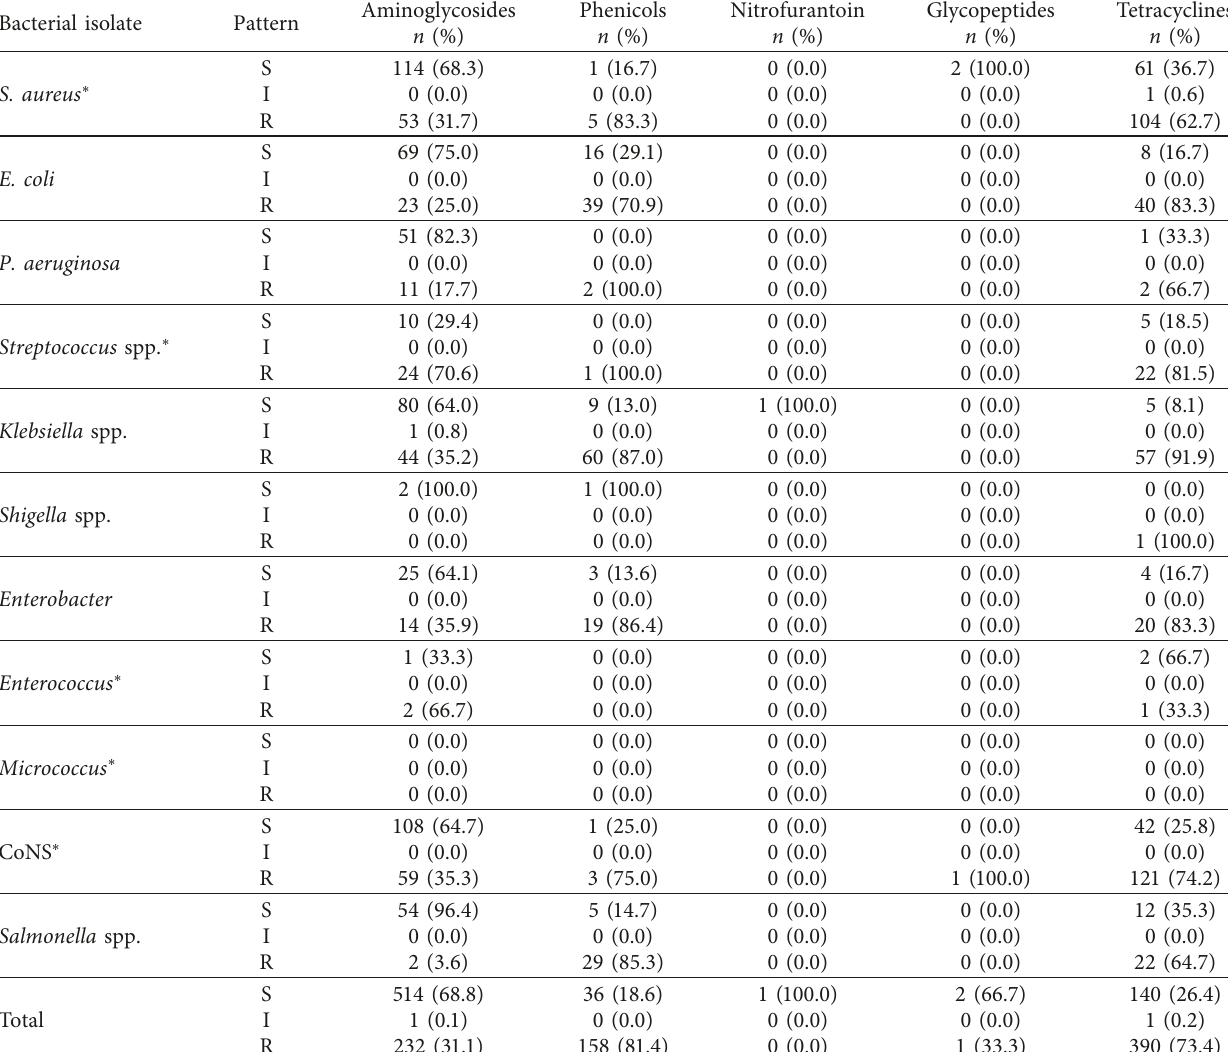
Table 4: Antimicrobial susceptibility pattern of bacterial isolates from blood culture at St. Dominic Hospital in Akwatia. Bacterial isolate Pattern